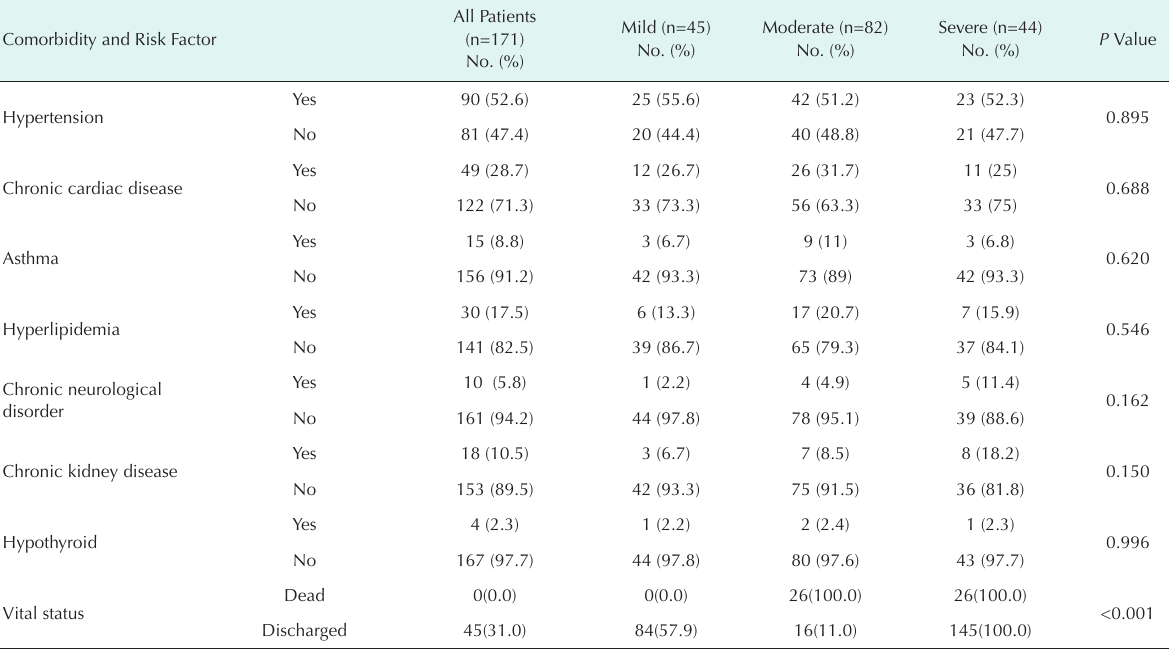
Table 2. The Association Between Different Groups of Severity With Comorbidities and Risk Factors Comorbidity and Risk Factor